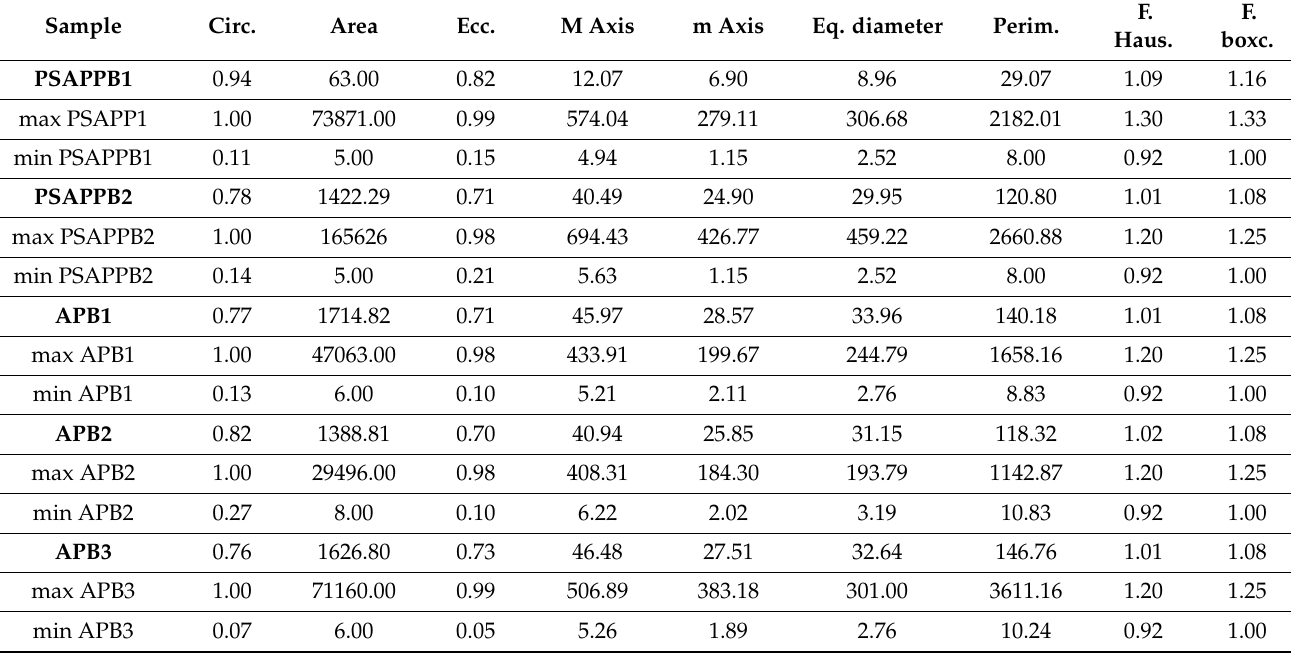
Table 2. Average values of the parameters identified for each class.